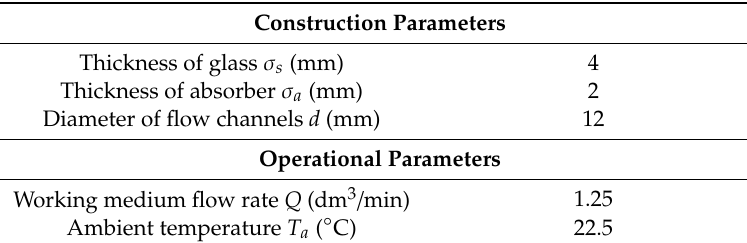
Table 1. Study object construction and operational parameters: basic values.